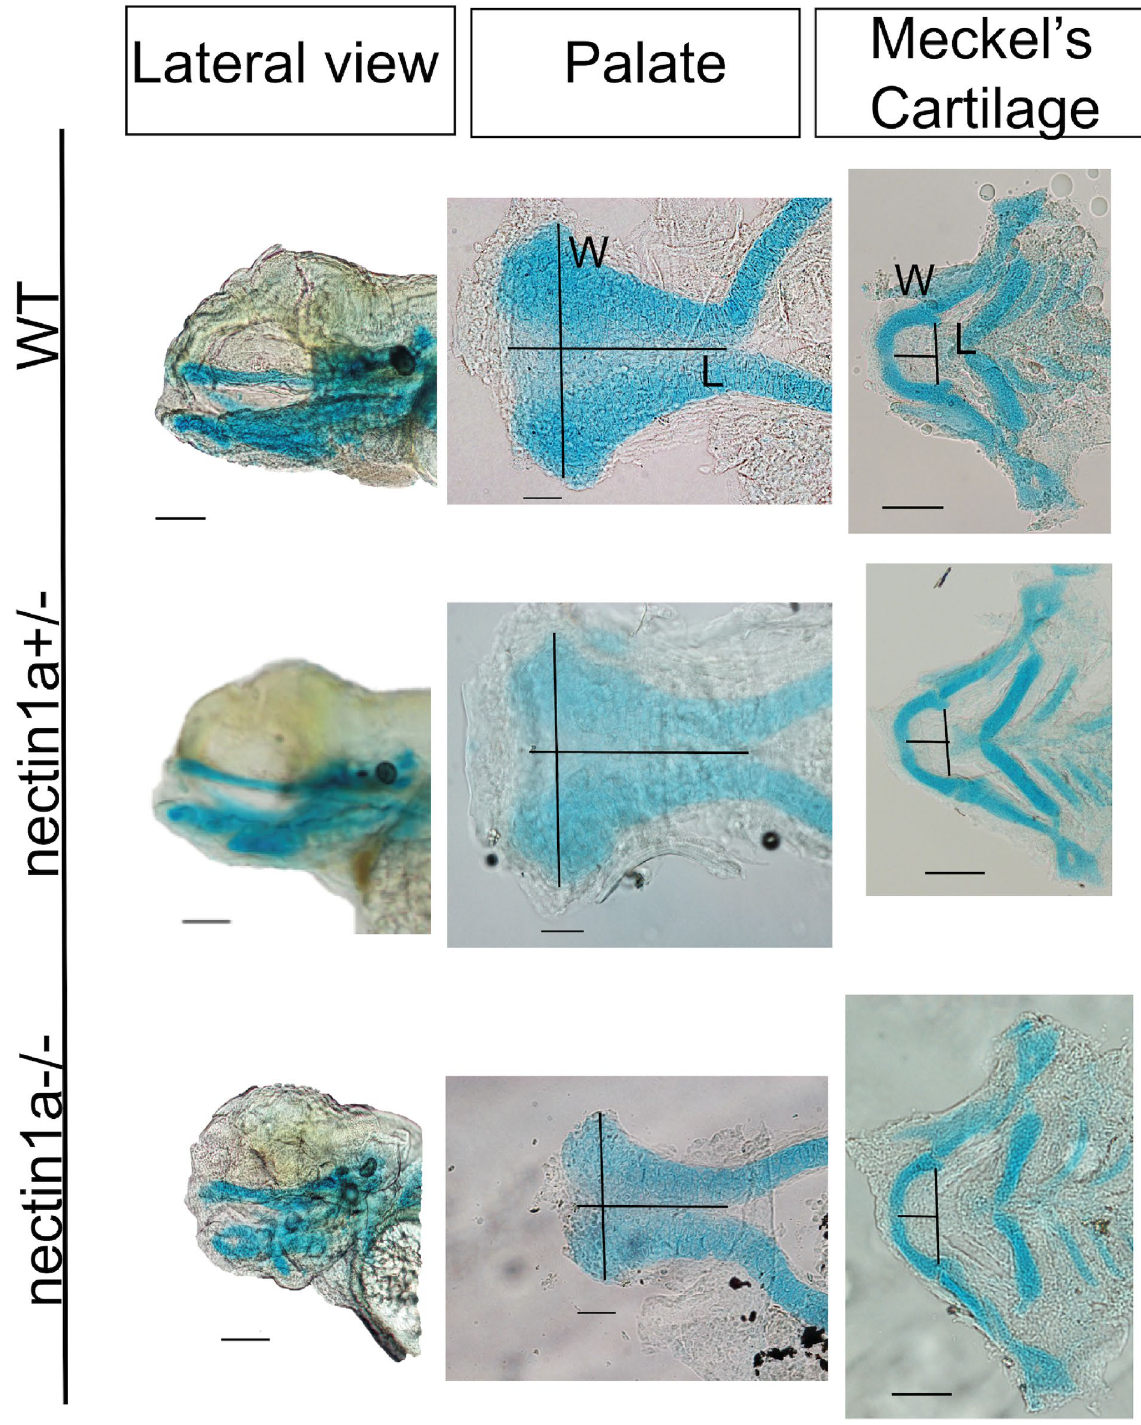
Figure 6. Alcian blue images for nectin1a zebrafish mutant compared to wild type at day 5. Top images: wild type alcian blue lateral view, palate and Meckel’s cartilage. Middle images: heterozygous nectin1a embryo alcian blue. Bottom images: homozygous nectin1a mutant lateral view. The length of the palate was measured from the anterior midpoint to the posterior midpoint of the palate. The width was measured as the maximum distance between the 2 lateral borders at the anterior area. The length of the Meckel’s cartilage was measured from the midline of the Meckel’s cartilage to the midline of an imaginary line drawn joining the joints between the Meckel’s cartilage and the palatoquadrate. The width was measured from the junction of the Meckel’s cartilage and the palatoquadrate of one side to the other side. Compared to wild type animals. nectin1a mutants have smaller and shorter palate, and shorter and wider Meckel’s cartilage. L length, W width. Scale bar: 10